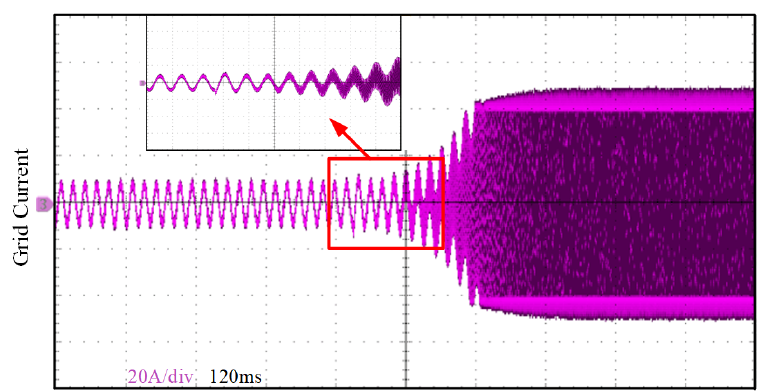
Figure 16. Grid current waveform when the lead Compensator G a is